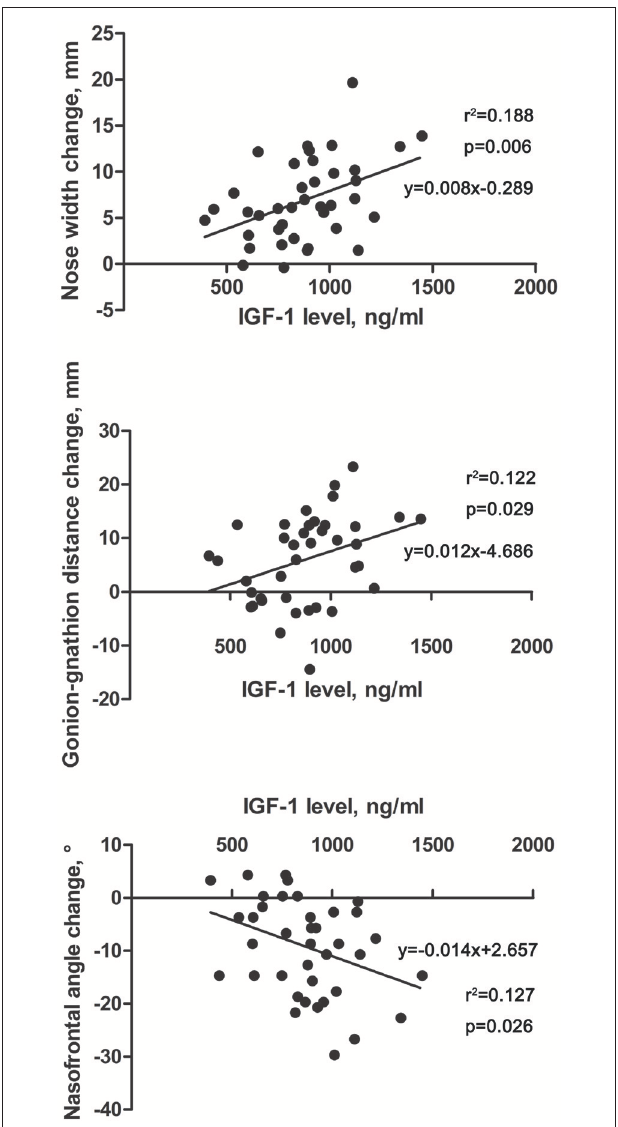
FIGURE 3 | Scatter diagrams revealing the correlations between IGF-1 level and facial parameter changes in acromegaly patients. The horizontal axis indicates the level of IGF-1, and the vertical axis indicates the facial parameter changes of the acromegaly patients compared with those of the healthy controls. Each point in the scatter diagrams represents the change in one patient. Linear-regression analysis was performed, and the fitting line and formula are